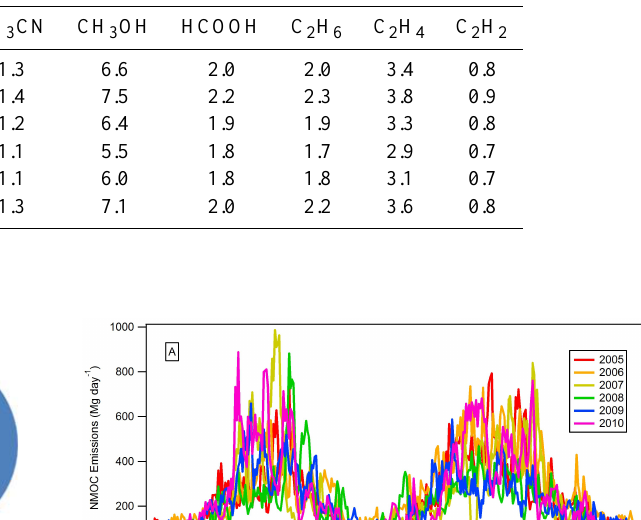
Table 10. Global emissions (Tgyr − 1 ) for selected species of the MOZART-4 chemical mechanism.